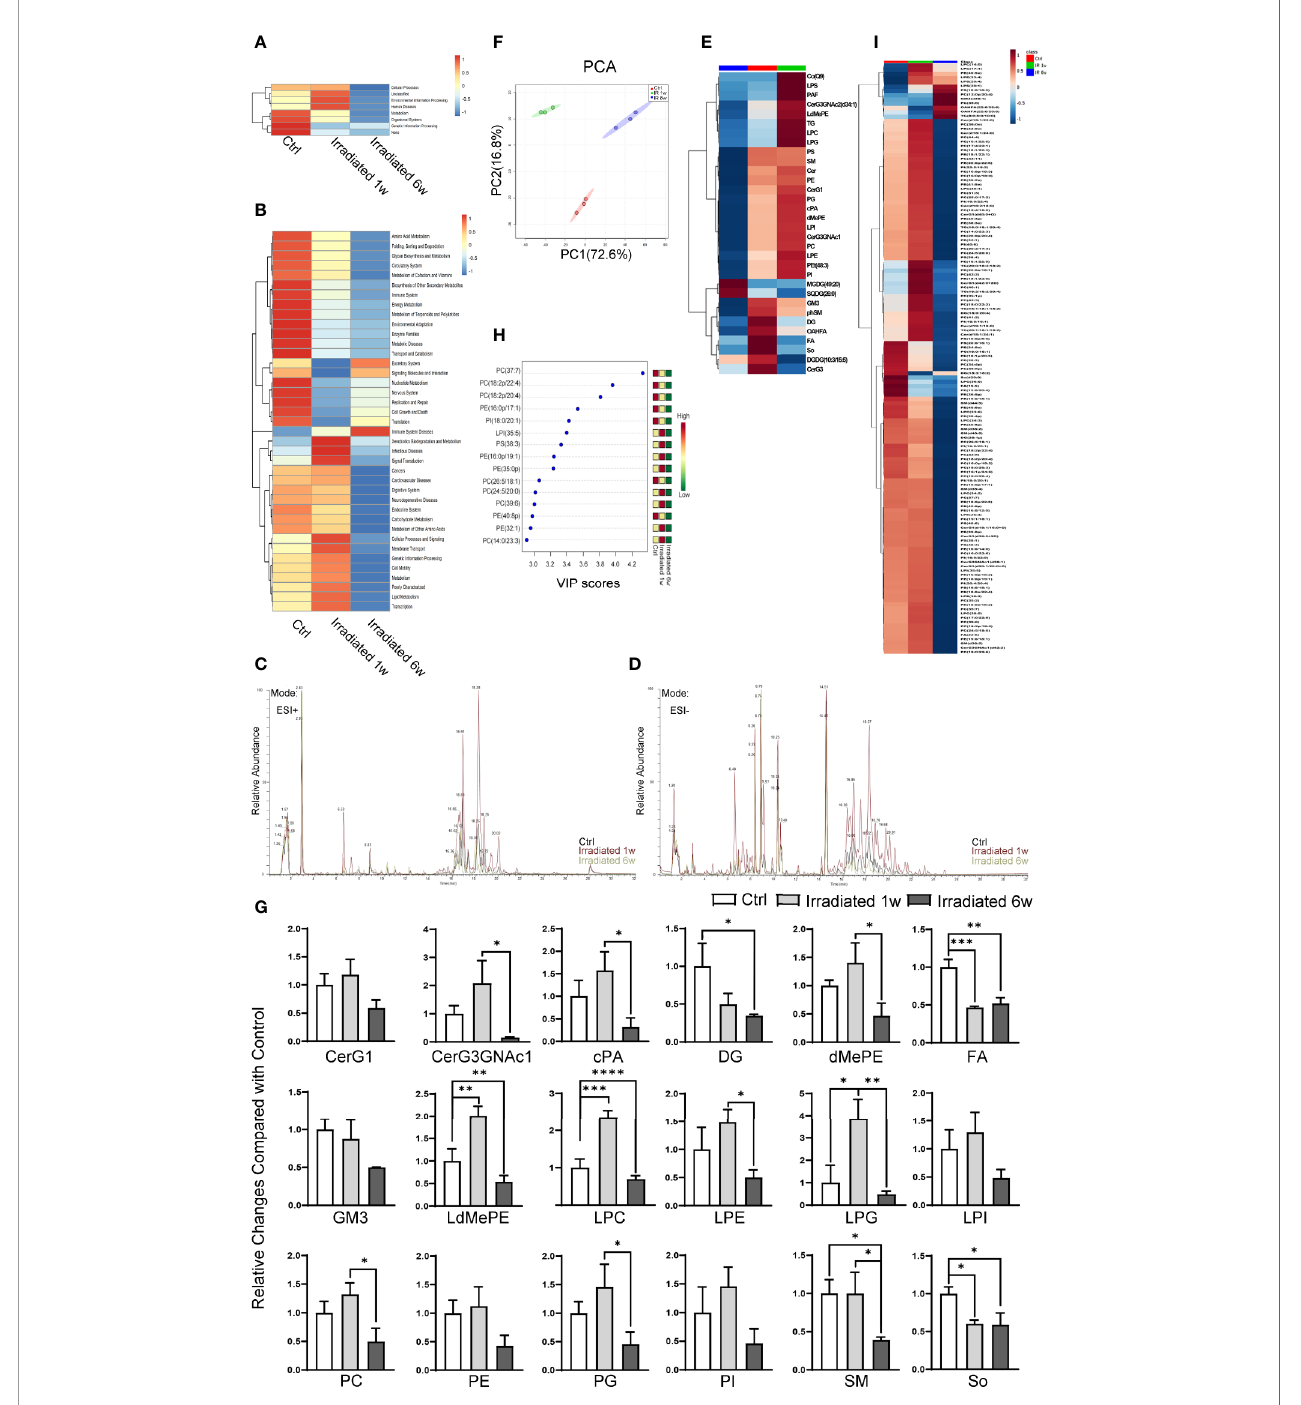
FIGURE 4 | Global lipidomics pro fi le alterations of intestinal epithelial tissues in RE mice. (A, B) Functional capabilities of microbial communities predicted by PICRUSt based on 16S datasets. (C, D) Representative MS spectra in both (C) ESI positive and (D) ESI negative ion modes for lipidomic pro fi le in irradiated and unirradiated groups. (E) Clustering patterns of lipid metabolite types in irradiated and unirradiated groups displayed by hierarchical clustering heatmap. (F) PCA scores plot based on lipid metabolites. (G) 18 signi fi cantly changed lipid categories in irradiated groups compared with control. (H, I) The top 15 and a total of 138 lipid metabolites signi fi cantly related to RE were identi fi ed by OPLS-DA. Signi fi cance levels are indicated as follows: ****q < 0.0001, ***q < 0.001, **q < 0.01, *q <